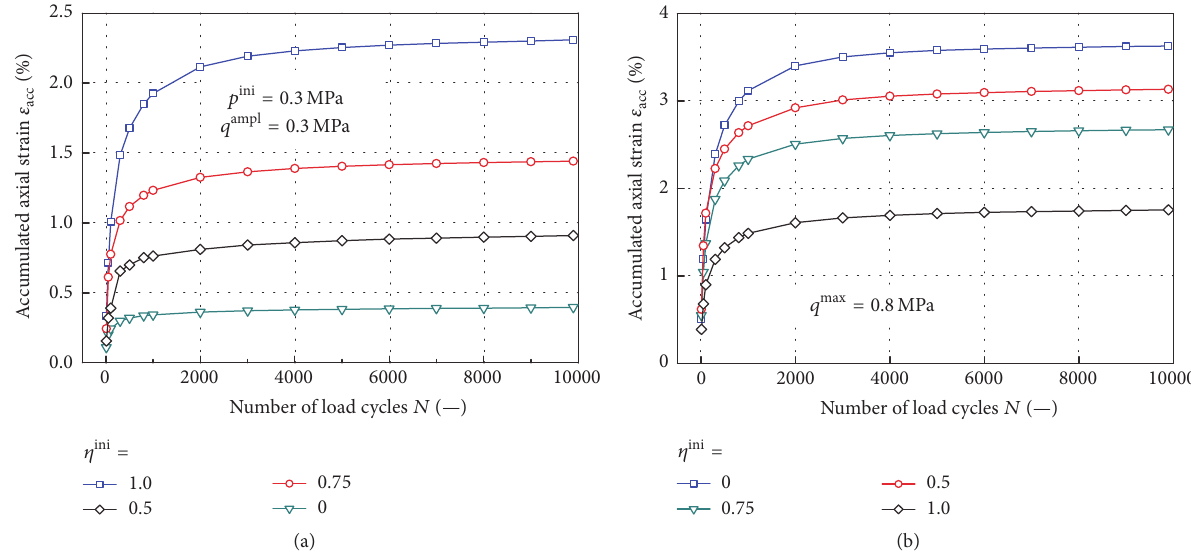
Figure 10: Test with different initial stress ratio; accumulated axial strain versus number of load cycles: (a) initial mean stress 0.3 MPa; (b) maximum deviatoric stress 0.8